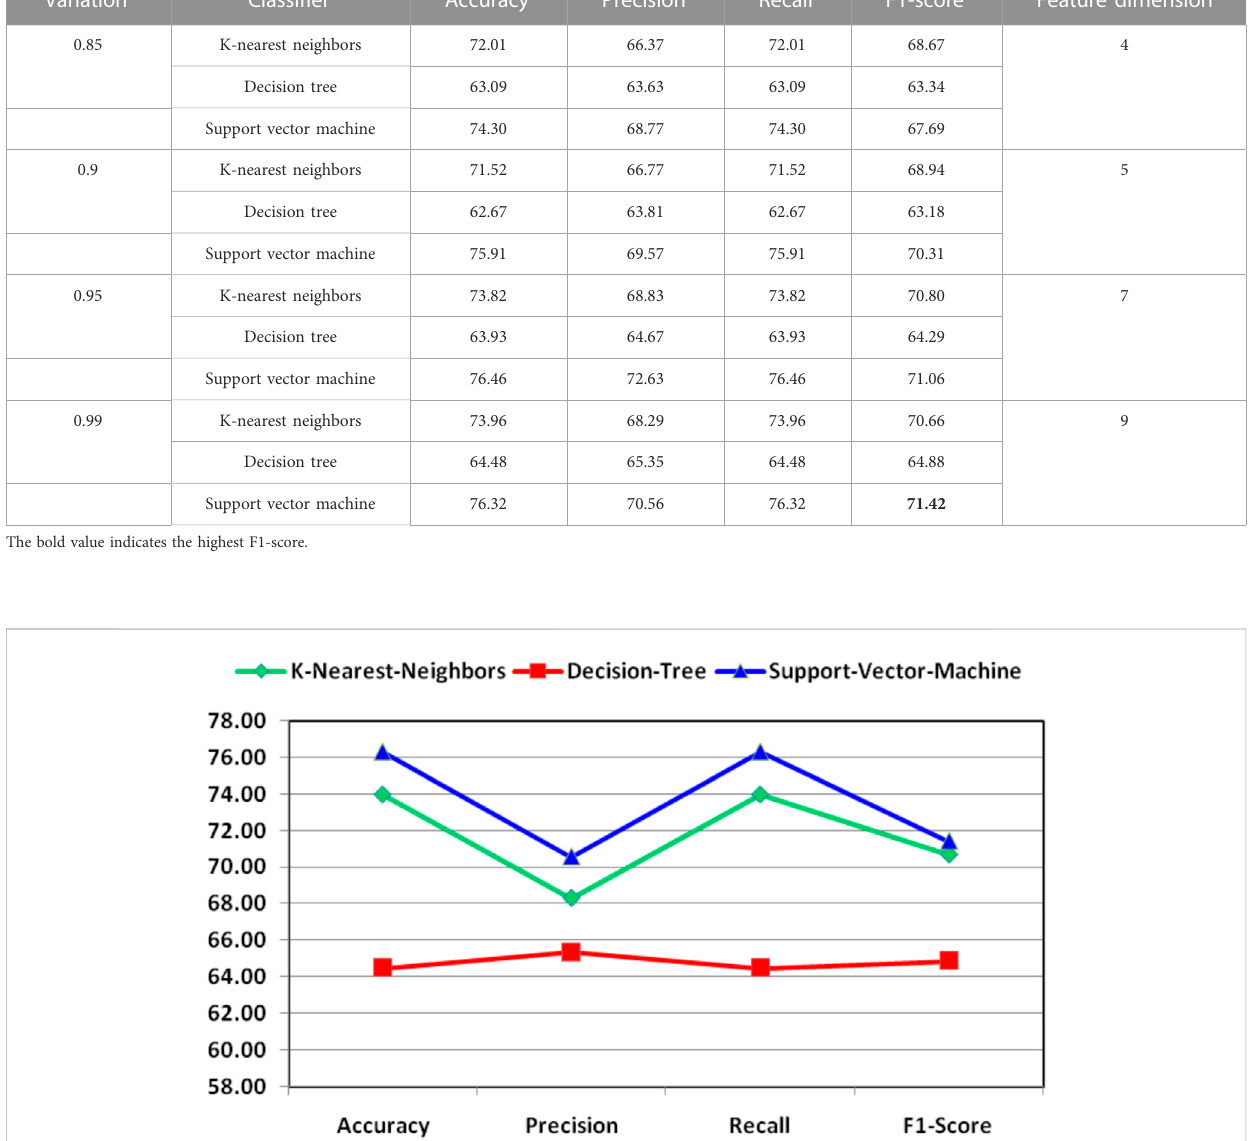
TABLE 10 Demonstration of performance due to combination of features for the classi fi cation of essential genes of AT, DOM, DR, HS, and MM species. Variation Classi fi er Accuracy